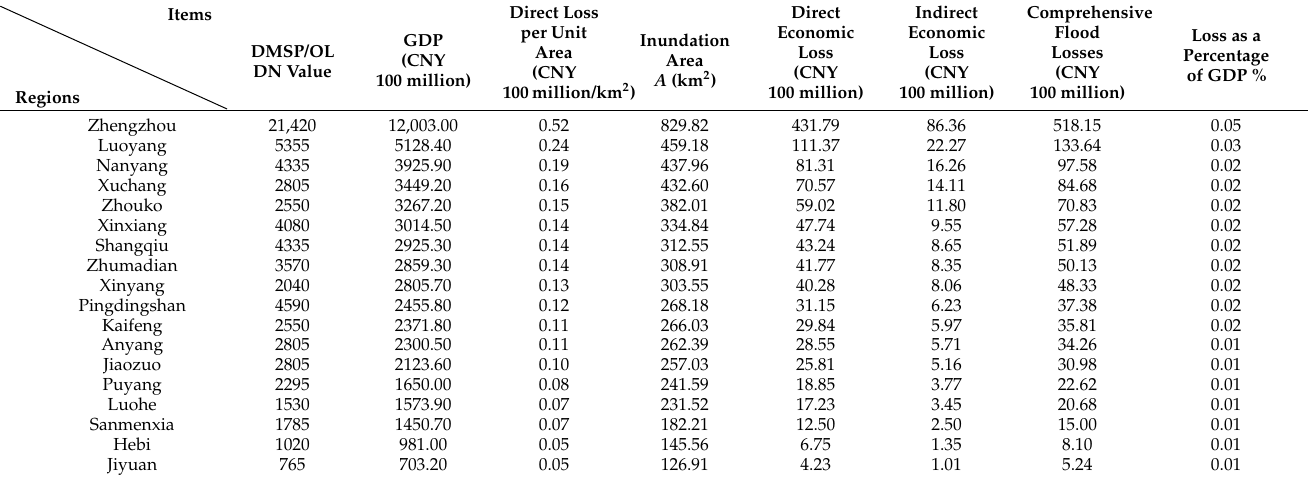
Table 4. Loss assessment for flood disasters in cities and counties of Henan Province.